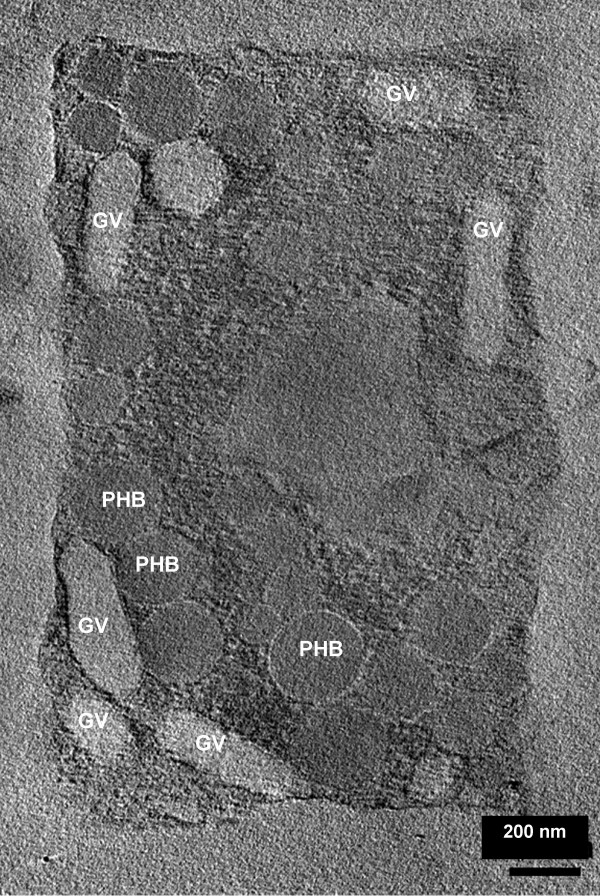
Electron Tomographic image of a single square cell of H, walsbyi. In agreement with previous observations, gas vesicles (GV) recognized by their spindle shape are found at the borders of the cell. The large number of circular electron-dense bodies are most likely poly-3-hydroxy-butyric acid (PHB) polymers consistent with Nile-Blue staining patterns [4]. The genes encoding PHB biosynthesis proteins have been identified (image by H. Engelhardt).